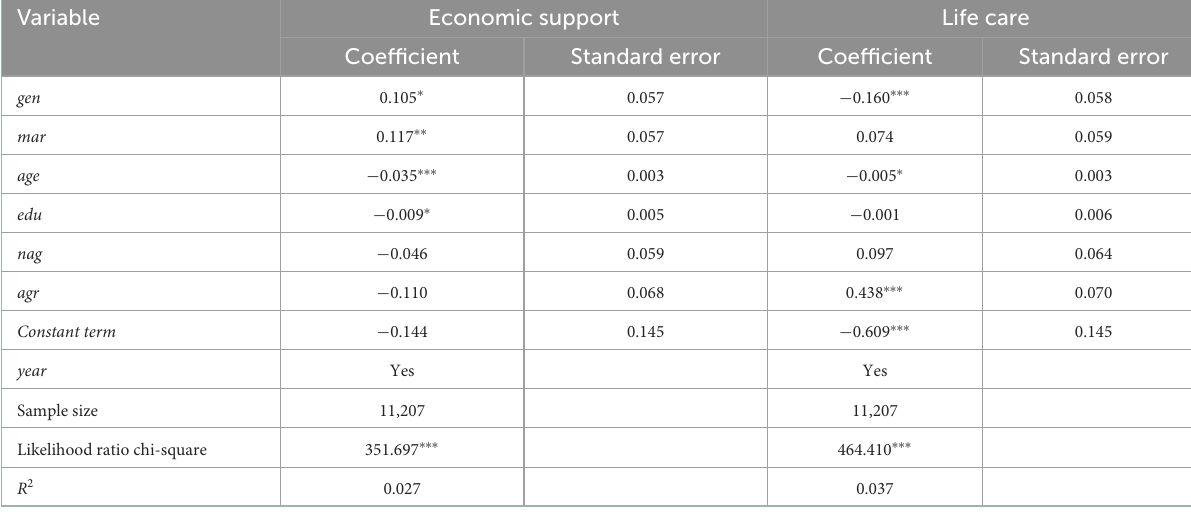
TABLE 4 Effects of children’s gender structure on intergenerational family support.